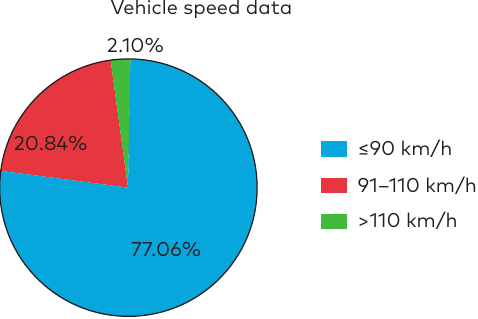
Figure 3. Speed data recorded by the average speed enforcement systems